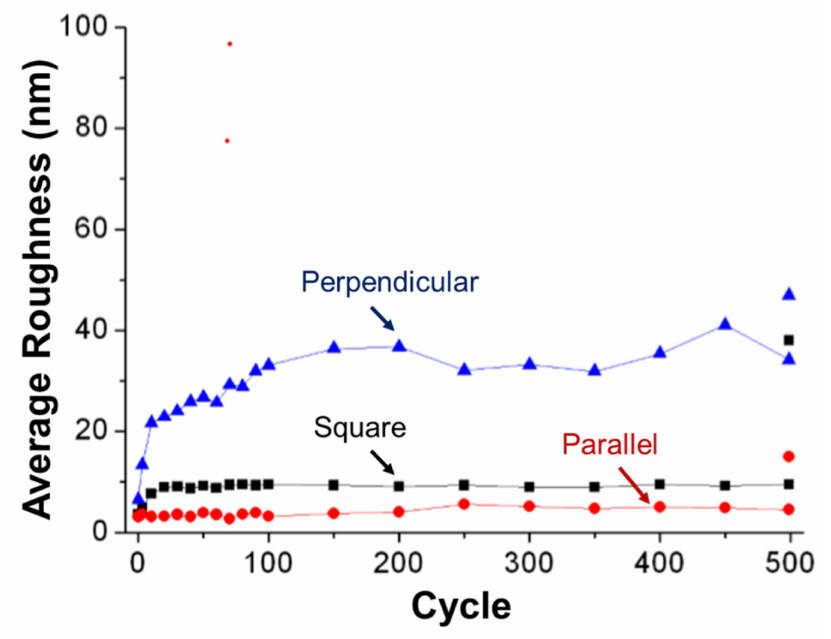
Figure 3. Average roughness for diamond sliding against tungsten using a macro-scale